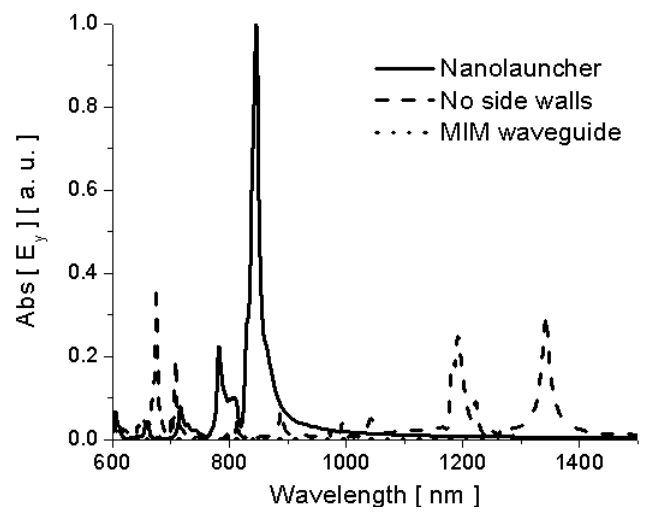
Figure 4. Simulation results for electric field amplitude inside the channel ( 10 nm from the exit) for the three geometries of Figure